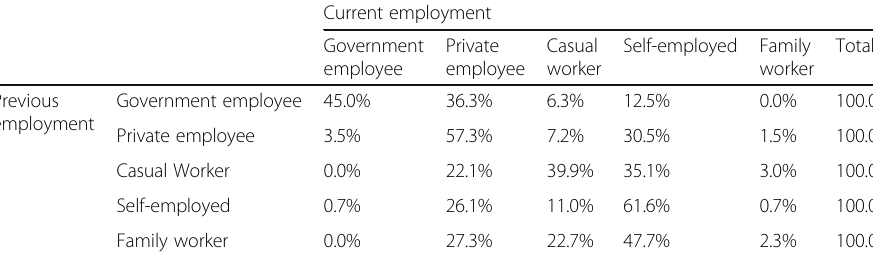
Table 10 Transition between employment categories